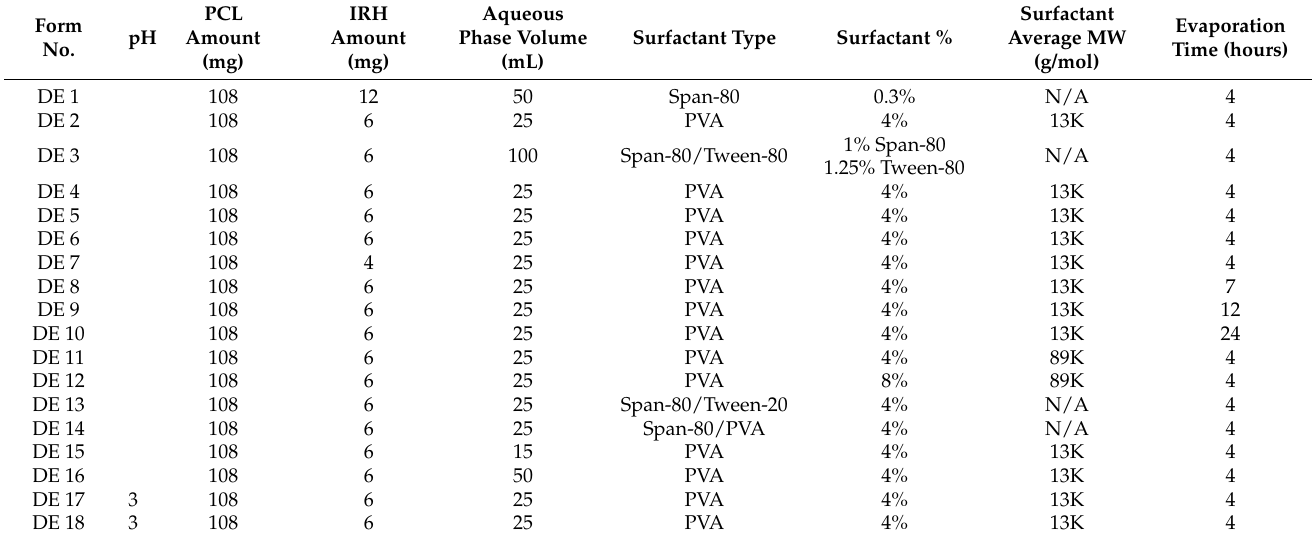
Table 2. Double emulsion parameters of optimized